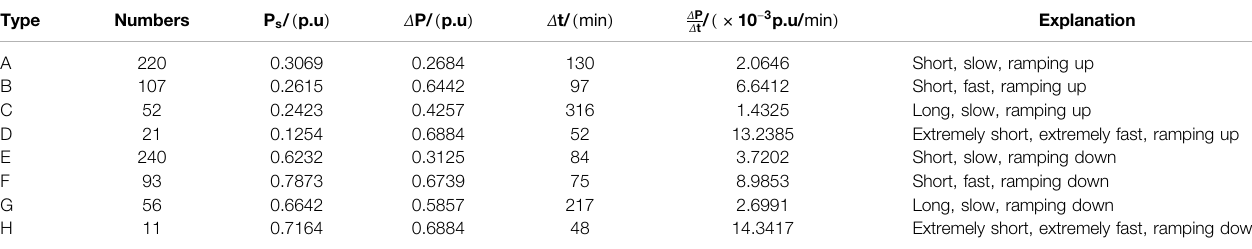
TABLE 1 | The classi fi cation of ramping events.